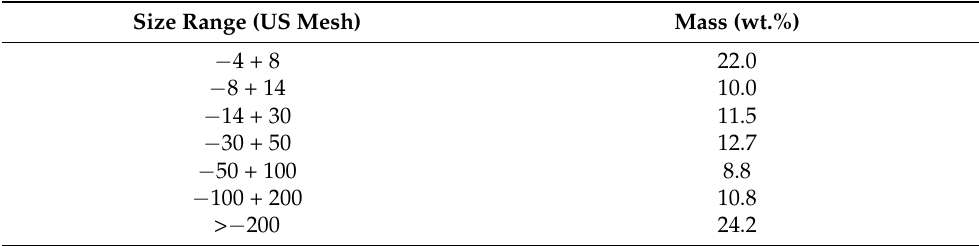
Table 1. Size distribution of coke aggregates in anode samples [26]. Size Range (US Mesh)